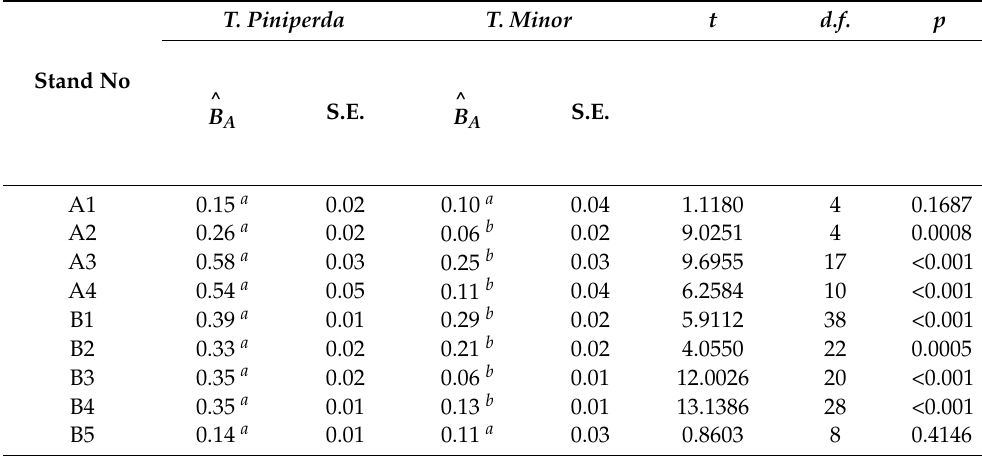
(cid:0) ˆ (cid:1) B A ( ± 1 S.E.) for pine shoot beetles inhabiting the same trap logs. T.